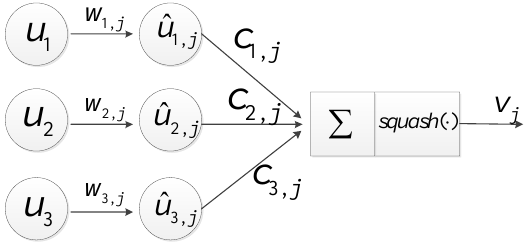
Figure 2. The schematic diagram of forward propagation of capsule